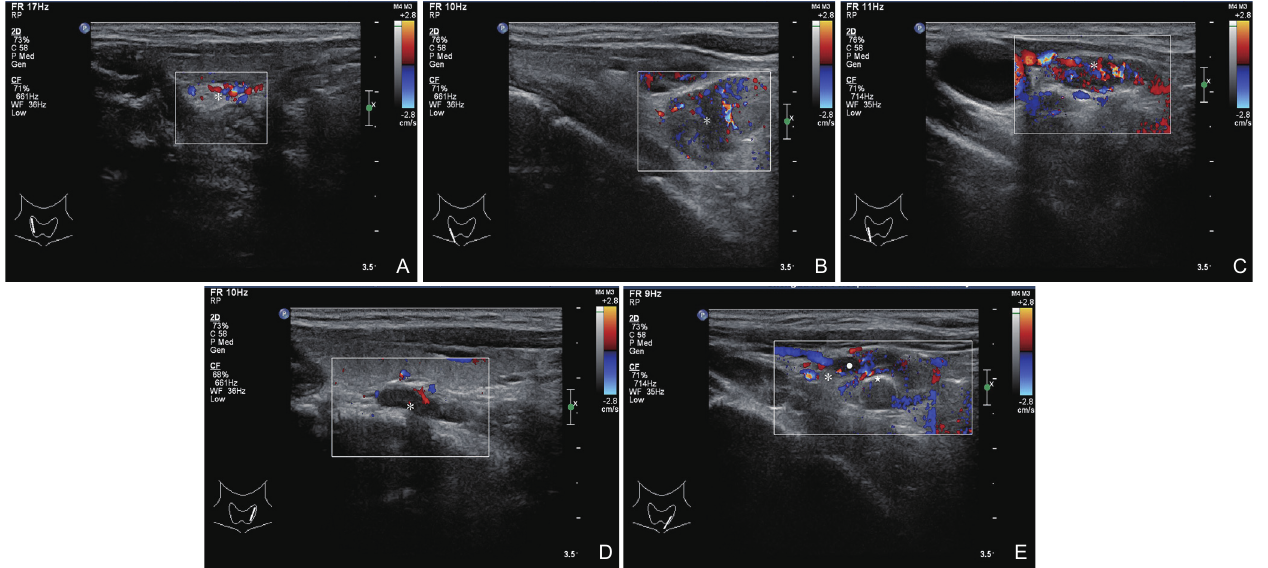
Figure 2 Sonographic images of PTGs of a 46 years old female patient in hyper-vascular subgroup. The total number of detectable PTGs was 5. Most of these PTGs (4/5) were hyper-vascular. (A) The longitudinal image showed the gland in right superior position (*), which was heterogeneously hyperechoic with the Doppler score Onoda was P1, C2; (B) The longitudinal image showed the gland in the right inferior position (*), which was medium heterogeneous, appearing to be partial hypoechoic and partial hyperechoic, The Doppler score Onoda was P2, C2;(C) The longitudinal image showed a supernumerary PTG gland (*) in the right inferior position, which shown to be homogeneous hypoechoic with Doppler score Onoda P2, C2; (D) The longitudinal image showed a gland (*) in the left superior position, which was slightly heterogeneous with Doppler score Onoda P1, C0; (E) The longitudinal image showed another gland (*) in the left inferior position, which was highly heterogeneous with annular calcification (white ★ ), cystic appearance (white circle) and Doppler score Onoda P1, C2. Table 1 Patients with ultrasonic detective PTGs in surgical and medication group Items Numbers of patients Numbers of PTGs in 4 classical positions Numbers of supernumerary PTGs Surgical Group